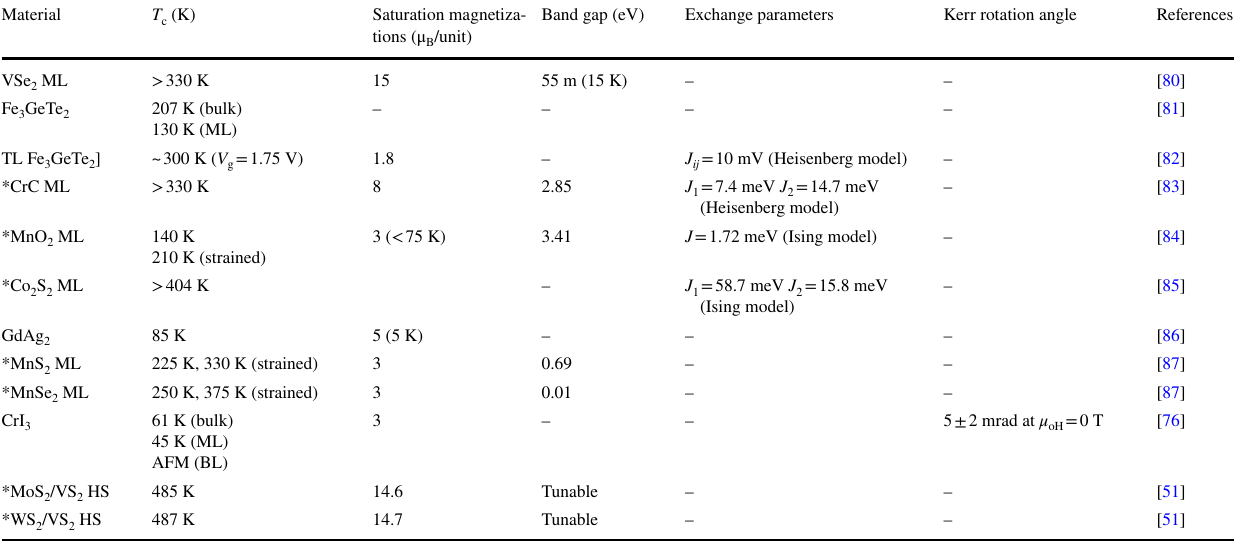
Theoretically predicted materials are marked by (*). The ML, BL, TL, and HS are short form of monolayer, bilayer, and heterostructure, respec‑ tively